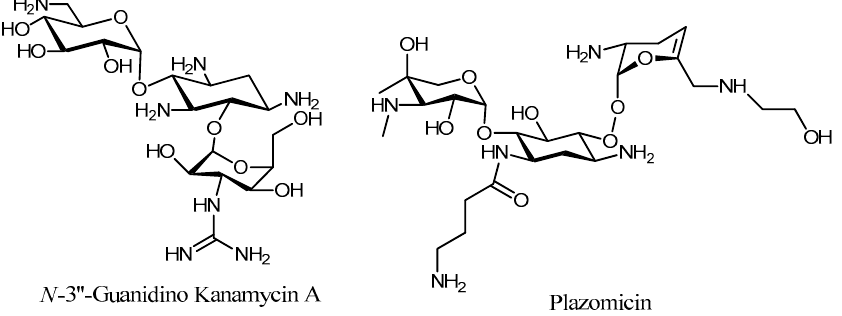
(cid:48)(cid:48) -Guanidino Kanamycin A and Figure 6. Structure of the N -3’’-Guanidino Kanamycin A and Plazomicin. Figure 6. Structure of the N -3